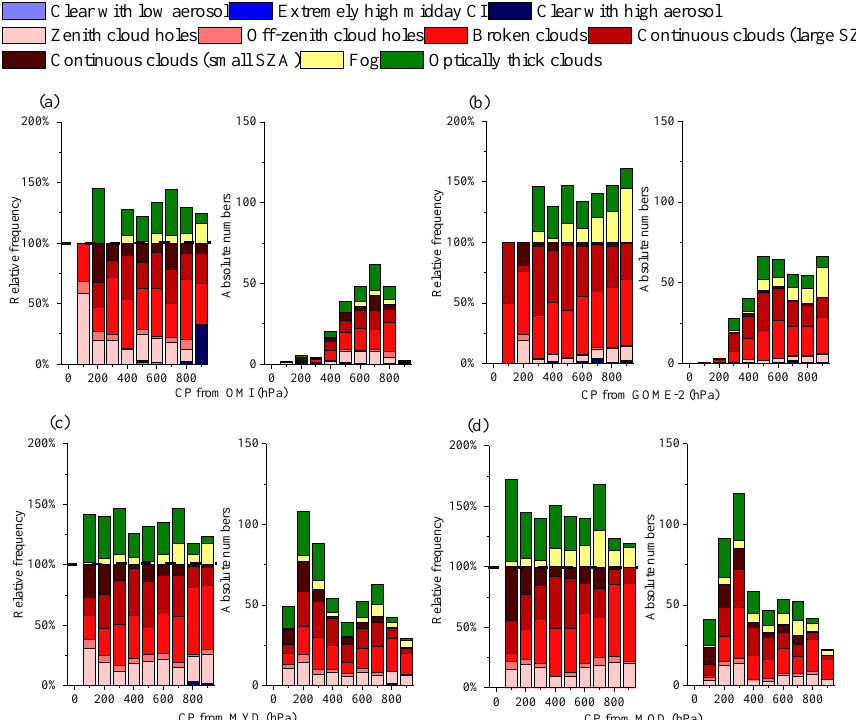
Figure 18. Results of the cloud classification scheme as a function of cloud pressure derived from different satellite observations for effective cloud fraction above 0.2; cloud pressure from (a) OMI, (b) GOME-2, (c) MODIS on Aqua and (d) MODIS on Terra. The left parts of the figures present the relative frequencies of the different sky conditions (see the caption of Fig. 10). The right parts of the figures present the absolute numbers of the sky